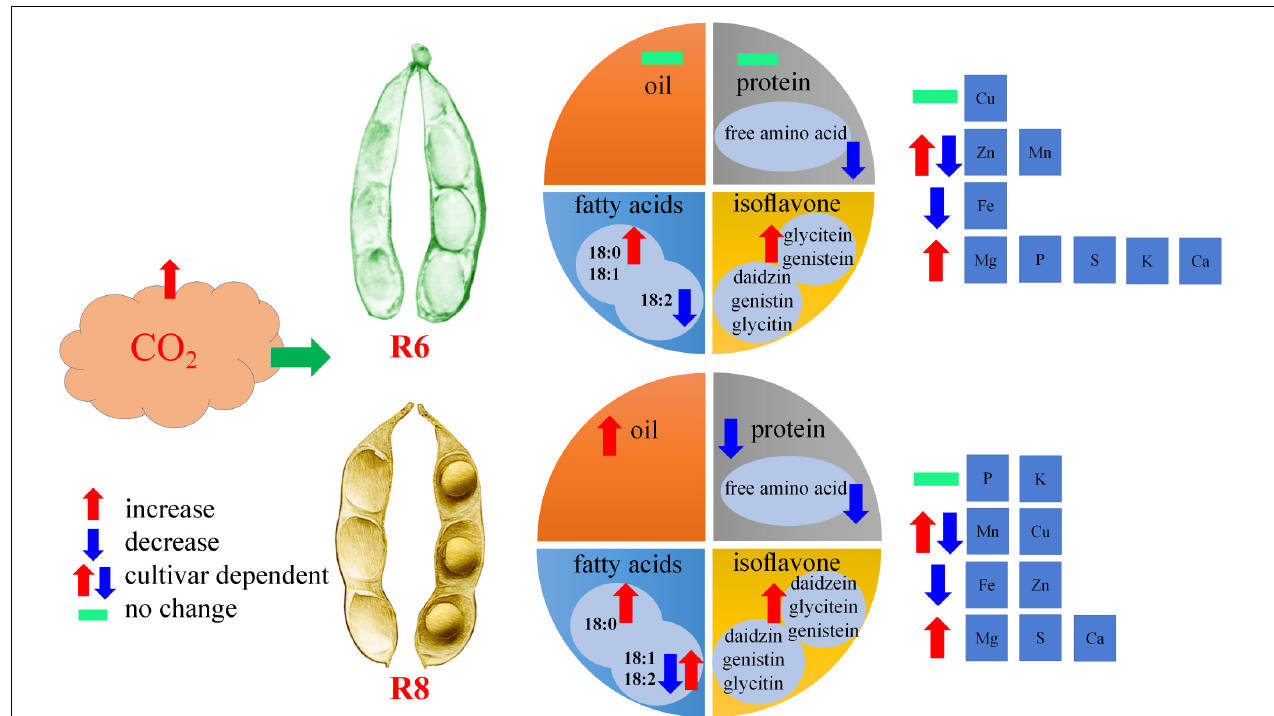
FIGURE 7 | Diagram illustrating the impact of elevated CO 2 on seed quality of soybean at the fresh edible (R6) and mature stages (R8).